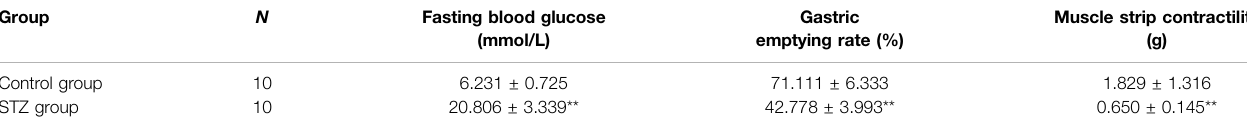
TABLE 2 | Comparison of fasting blood glucose, gastric emptying rate and gastric muscle strip contractility in STZ group and normal group. Group